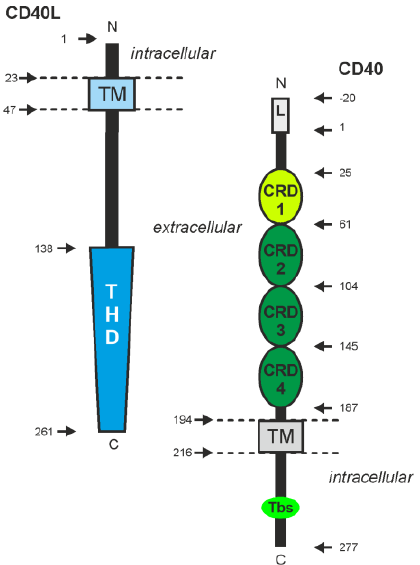
Figure 1. Domain architecture of CD40 and its ligand CD40L/CD154. CRD1 to CRD4 define CD40 as a TNFR. CRD1 is also functionally defined as pre-ligand binding assembly domain (PLAD), which mediates low-affinity CD40 self-assembly in the absence of CD40L. The TRAF binding site (Tbs) consisting of the amino acid motif PVQET is shown in overproportional size. The THD (TNF homology domain) defines CD40L as a member of the TNFSF. Arrows indicate amino acid positions according to the mature full-length proteins.